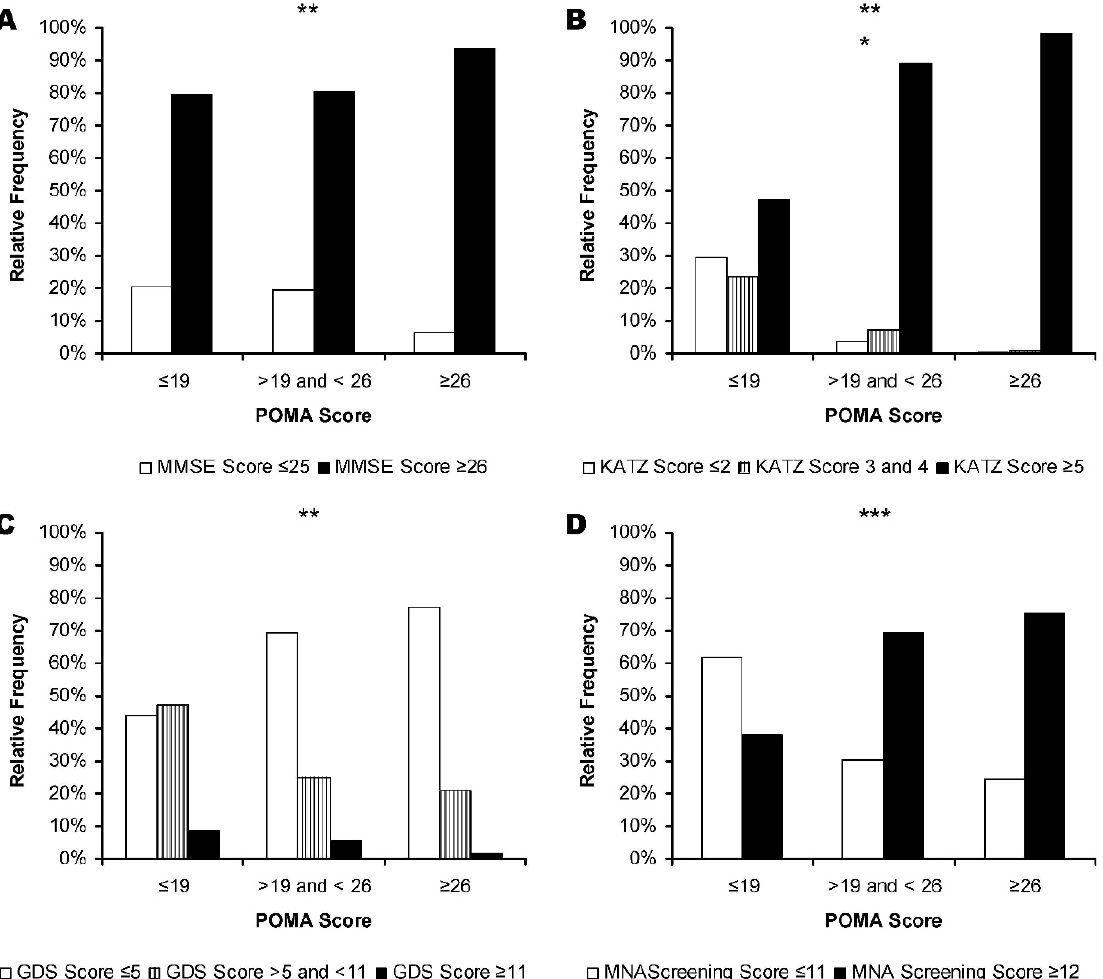
Figure 4 - Graphs depicting the relative frequency of individuals in a given MMSE (A), Katz (B), GDS (C) and MNA (D) score range per POMA score range. ** p , 0.01; *** p ,